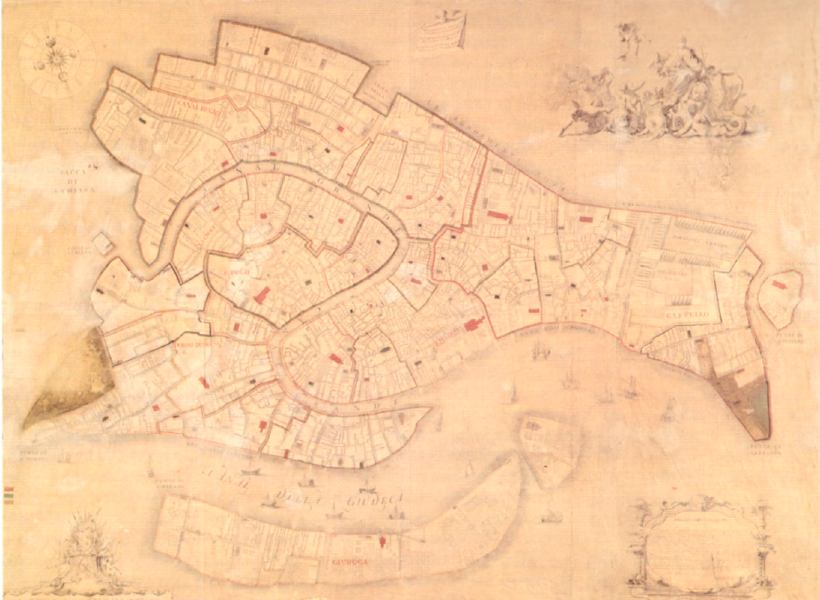
Figure 2. G. Selva, copy of the map made by L. Ughi in 1792 entitled iconographic representation of the inclusive city of Venice consecrated to the royal Venetian dominion. The paper shows the analyzes carried out by Selva on the city, 1807.